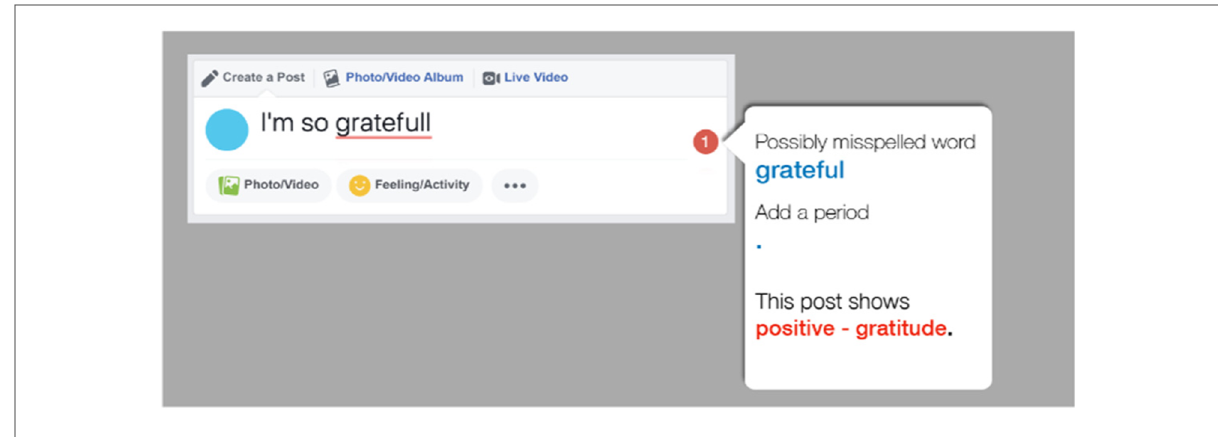
FIGURE 4 An example of the modi fi ed Facebook page using the message production aid.